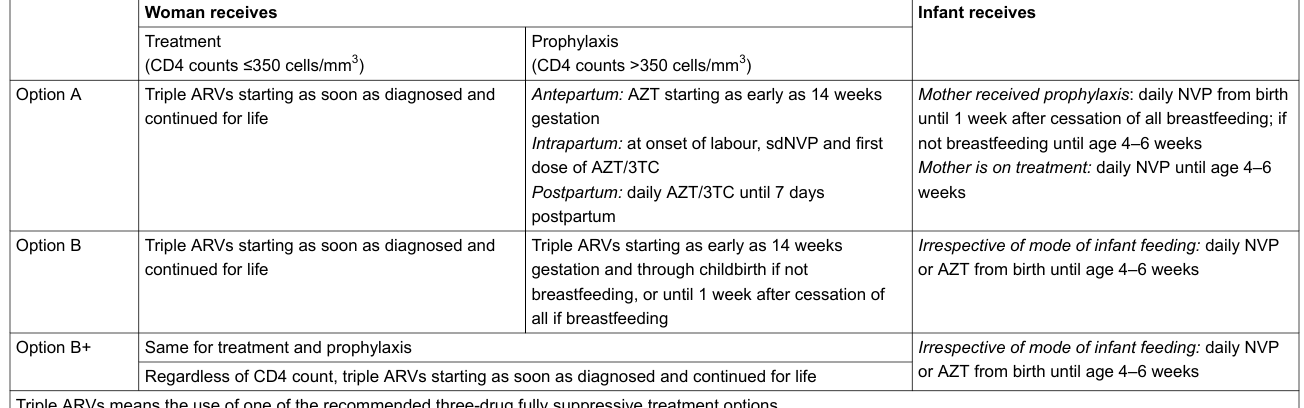
Prophylaxis (CD4 counts >350 cells/mm 3 )